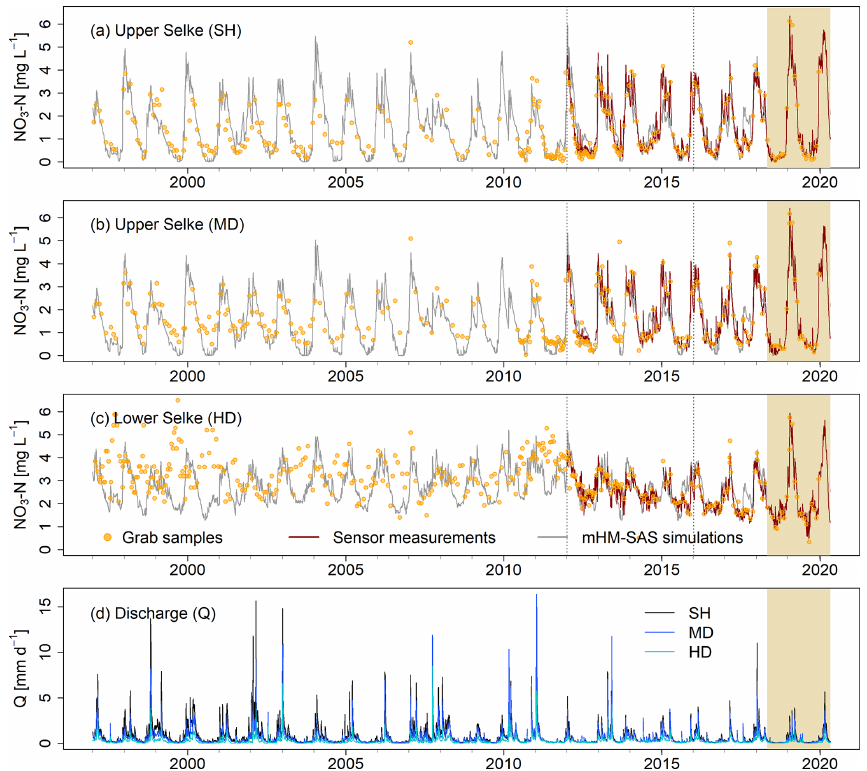
Figure 2. Nitrate as nitrogen concentrations and discharge at the gauging stations of the three Selke sub-catchments (1997–2020) with low-frequency grab samples (orange dots), simulated concentrations via mHM-SAS (grey line), daily averages of high-frequency sensor measurements from 2012 (red line), and daily discharge (bluish lines). Dashed lines indicate the mHM-SAS calibration (2012–2015) and validation (2016–2020) periods, comparing simulated nitrate-N concentrations with daily averages of sensor